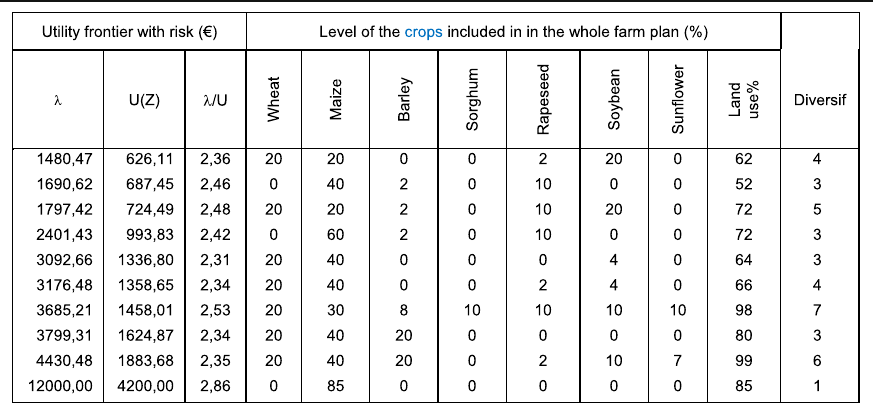
Table 4 Corner solutions and crop diversification